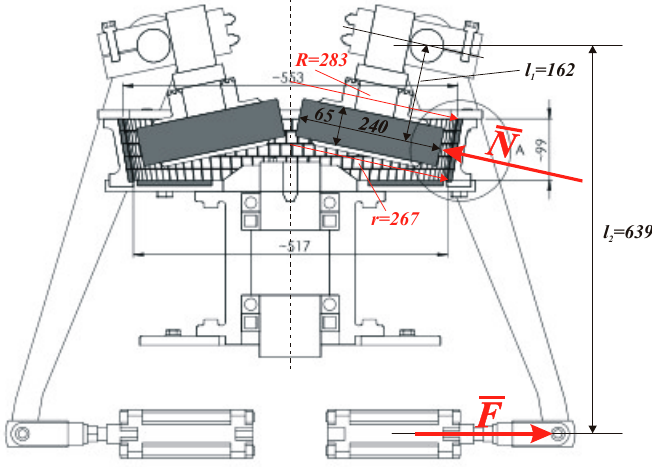
Figure 6. Cross-section of regeneration device.